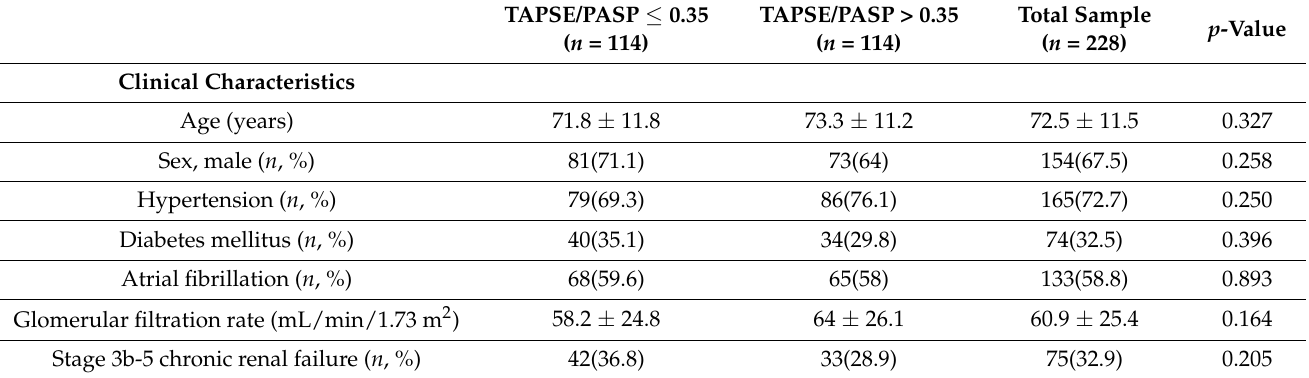
Table 1. Baseline characteristics according to